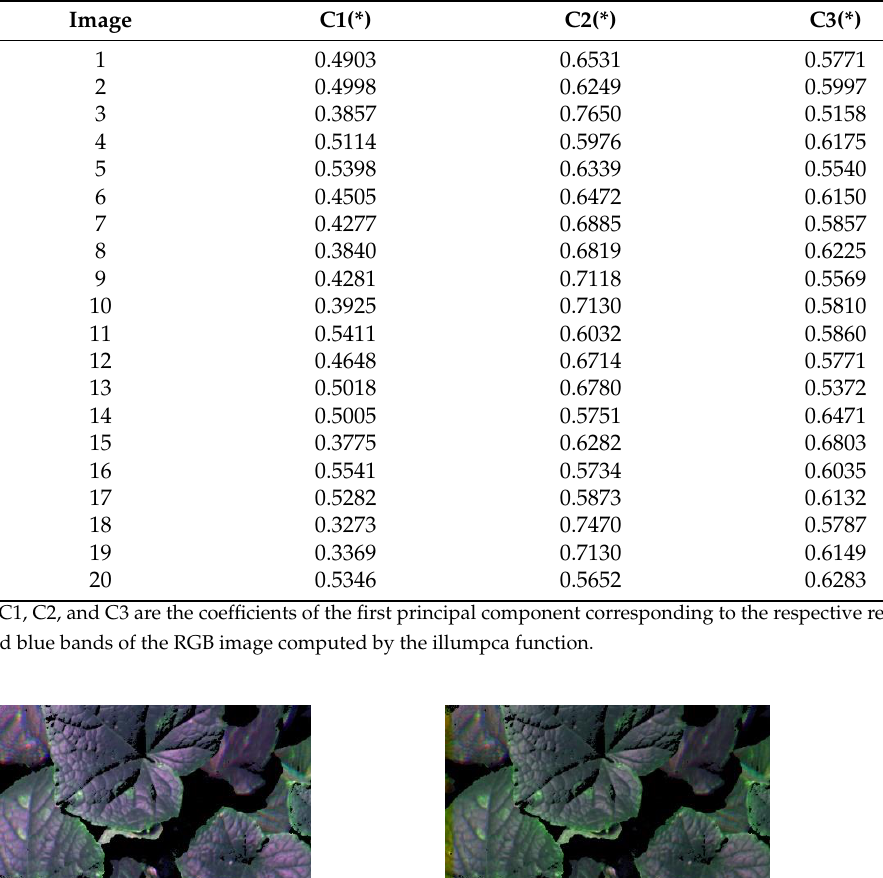
Table 3. First principal component coefficients estimated with the illumpca function applied to 20 aligned RGB images acquired over cucumber plants with a Micasense© Red Edge camera.